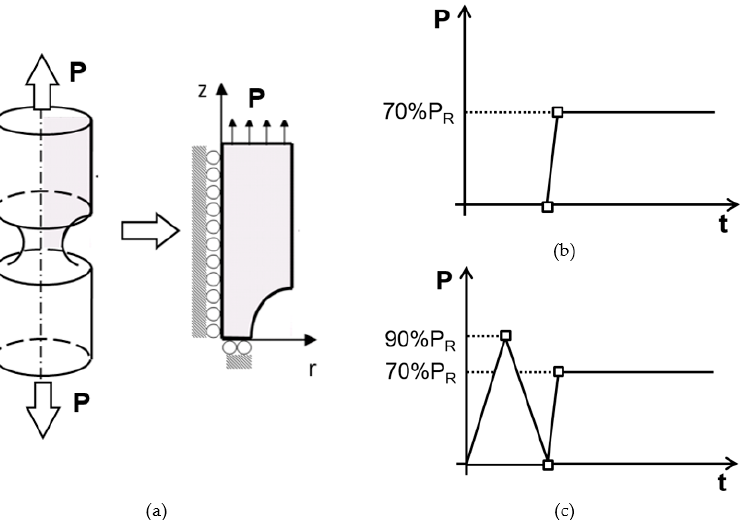
Figure 2. ( a ) Scheme of the reduction in the 3D geometry to an axisymmetric case including the imposed boundary conditions and load history: ( b ) without preload and ( c ) with preload.